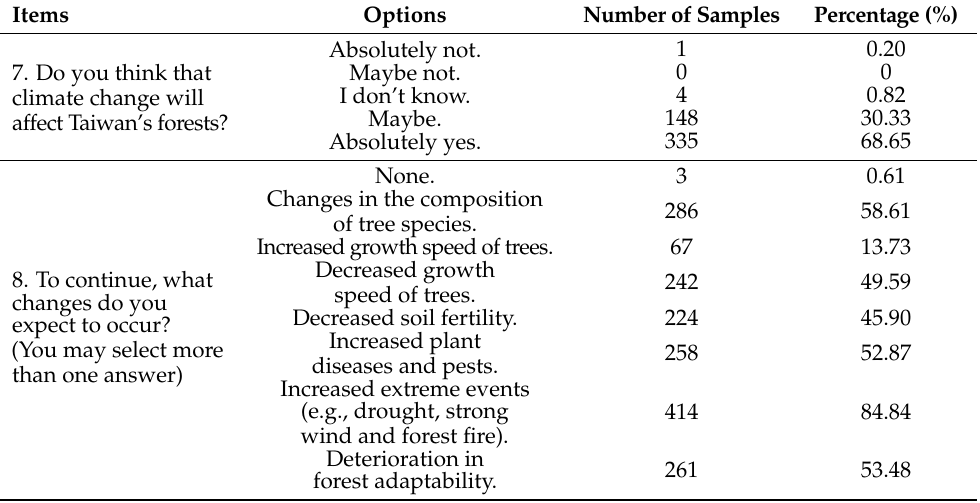
Table 6. Respondents’ thoughts on the potential effects of climate change on